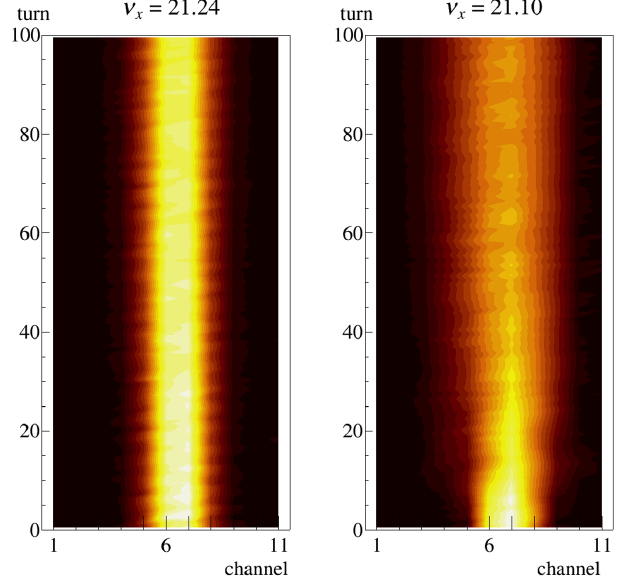
FIG. 4. Integrated signals of Inj-MRPM in the horizontal plane as a function of turns. The figure on the left shows the result corresponding to the condition of ( ν x , ν y Þ ¼ ð 21 . 24 ; 21 . 43 Þ , and the one on the right shows that corresponding to the condition of ð ν ; ν Þ ¼ ð 21 . 10 ; 21 . 43 Þ . The horizontal axes represent the x y channels and the vertical axes represent the turns. The pitch of the adjacent channels was 4.5 mm.